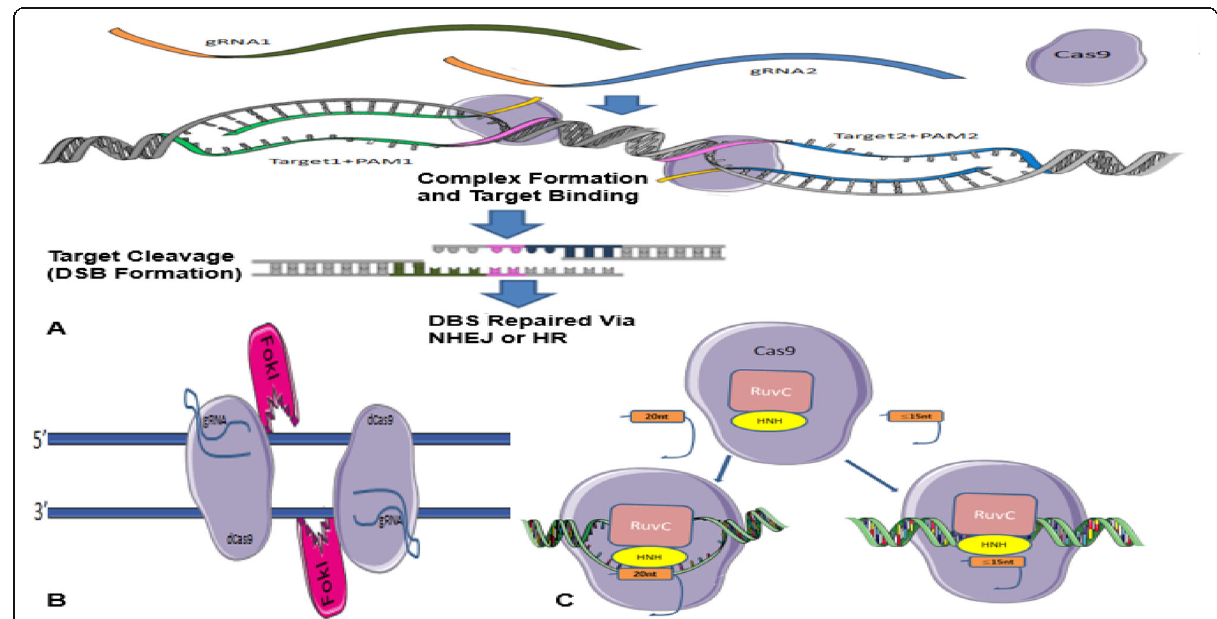
Fig. 4 a Summary of the Cas9 nickases methods in efficient genome editing. Two gRNAs target opposite strands of DNA. These double nicks create a DSB that is repaired using non-homologous end joining (NHEJ) or edits via homology-directed repair (HDR) (adapted from www. addgene.org/crispr/nick). b FokI-dCas 9 fusion protein method. Two FokI-dCas9 fusion proteins are used to adjacent target sites by two different sgRNAs to facilitate FokI dimerization and DNA cleavage. These fusions would have enhanced specificity compared to the standard